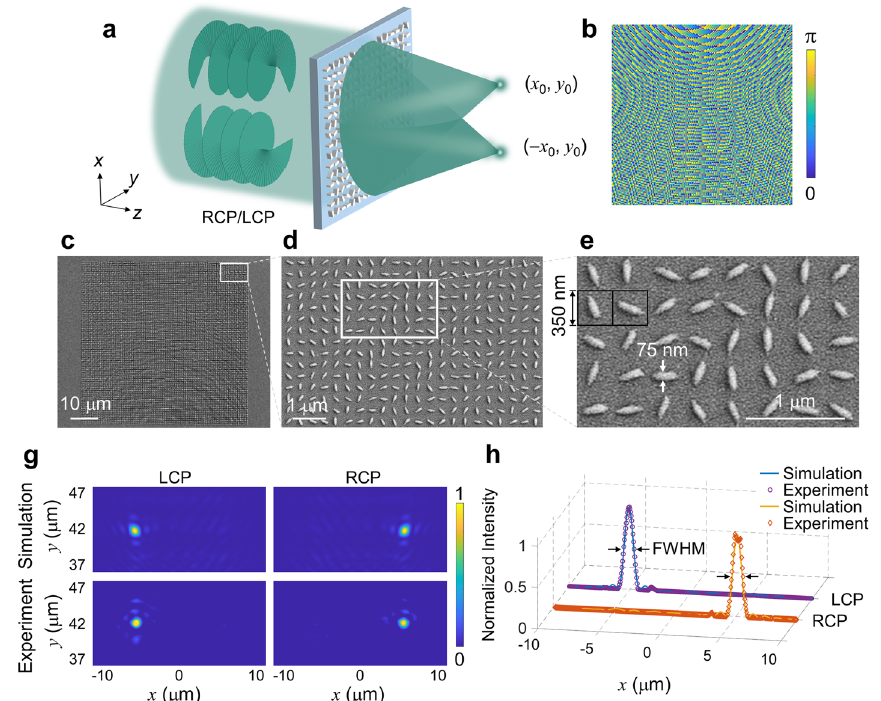
Fig. 5 Design, fabrication, and characterization of the spin-decoupled metasurface. a Schematic of the spin-decoupled metasurface. Different spins are transformed into two separated foci. b Nanorod orientation profile of the targeted spin-decoupled metasurface. c‑e Scanning electron microscope (SEM) image of the spin-decoupled metasurface fabricated by SC-PPI, together with magnifications ( d and e ) of the SEM images of the specified areas. g Simulated and measured focusing patterns for different spins. h Simulated and measured intensity profiles for LCP and RCP incident light. The full width at half-maximum of both intensity profiles is 815